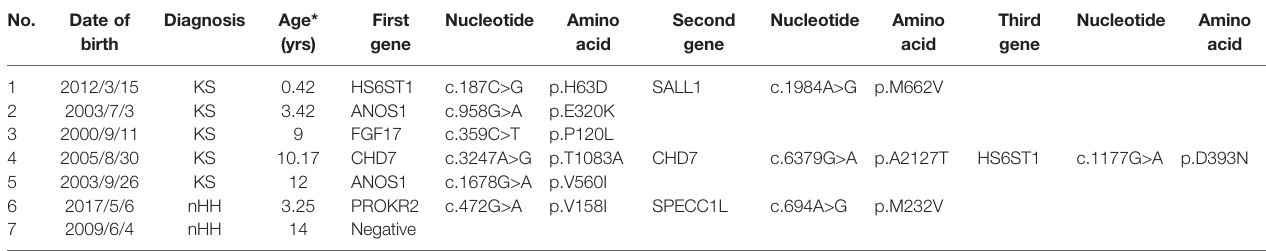
TABLE 1 | Genetic results of 7 patients with